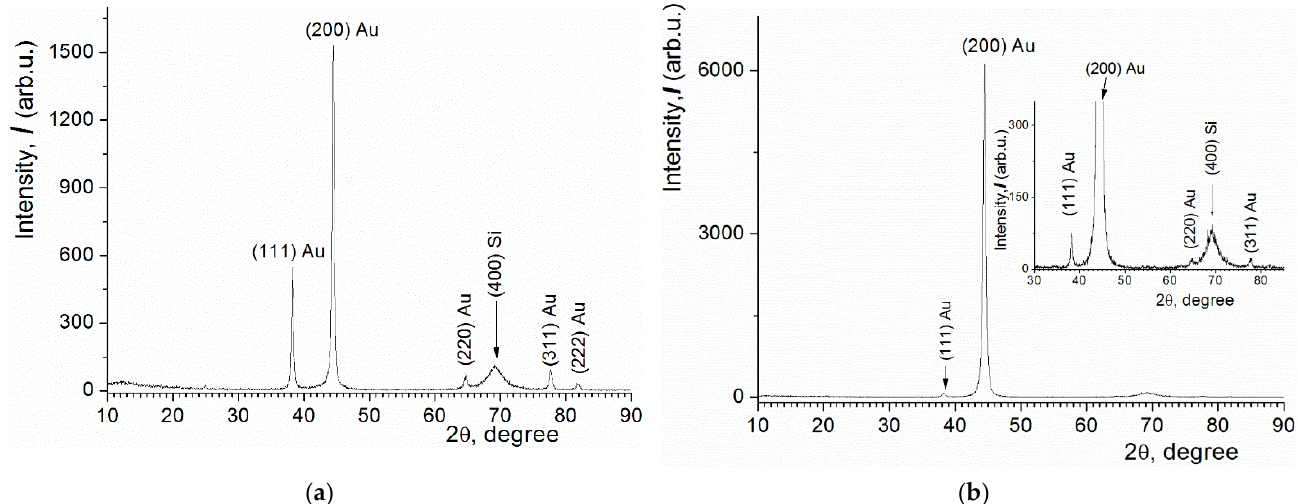
Figure 4. XRD pattern after 30 min ( a ) and 70 min ( b ) of Au deposition on the meso-PS with 49% porosity.